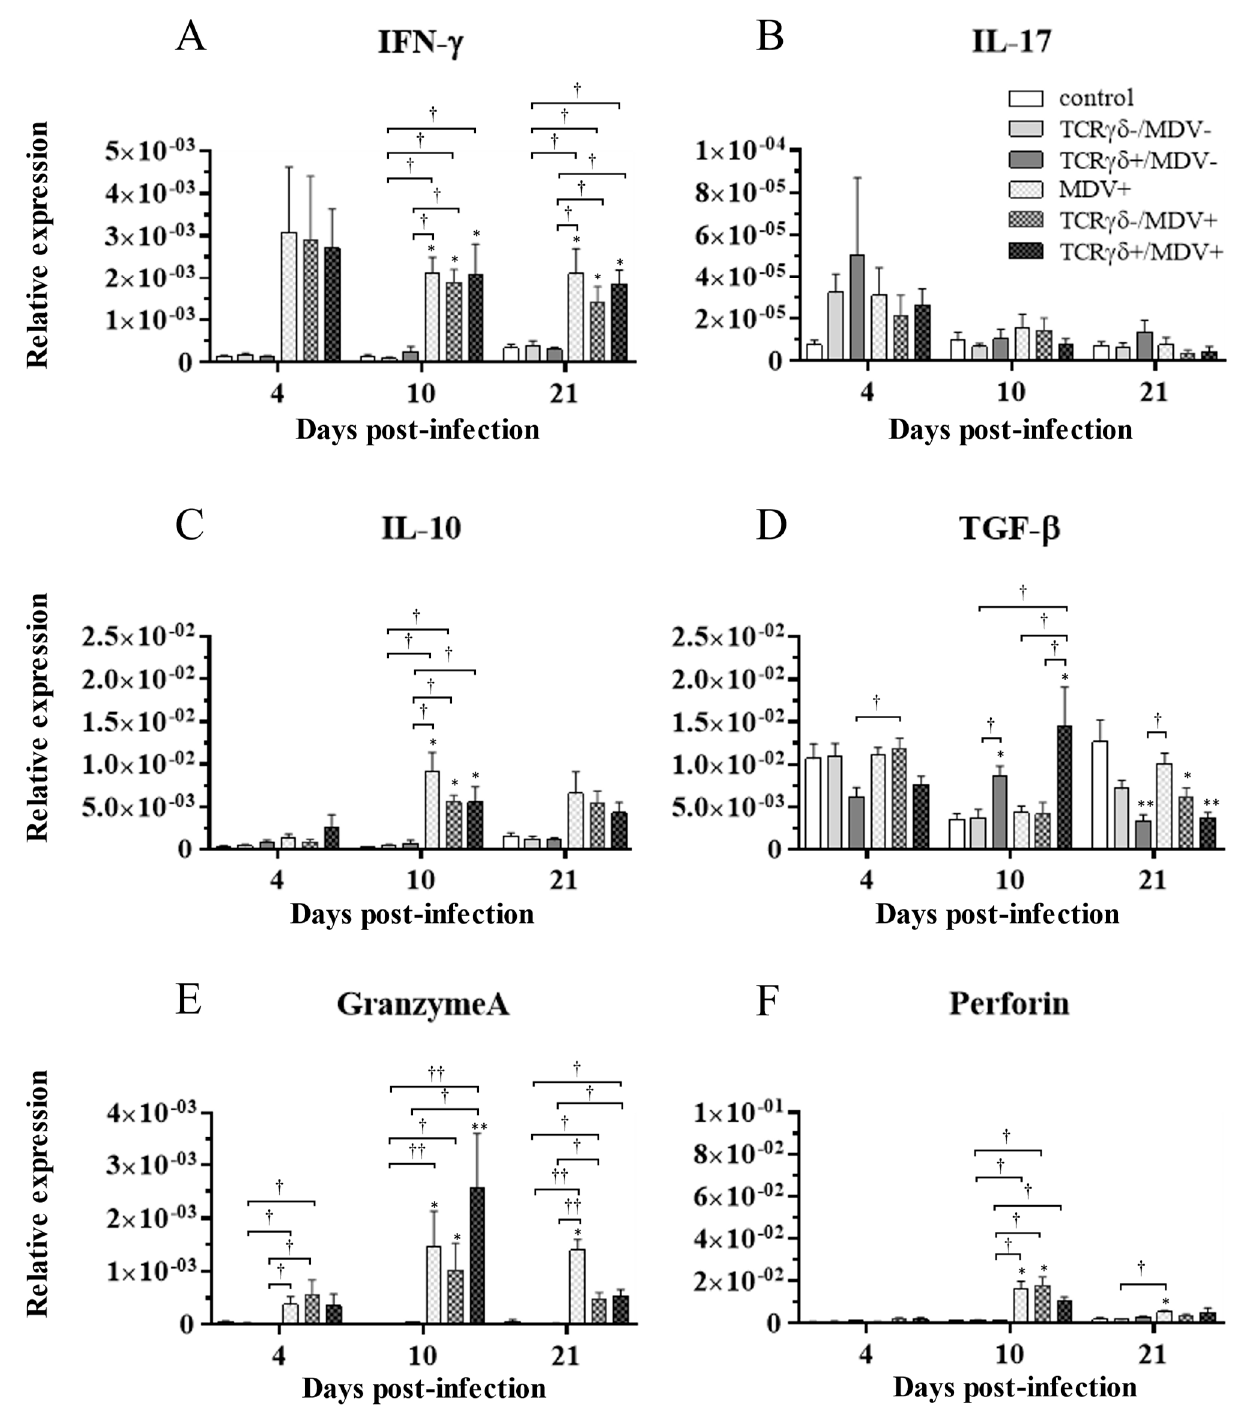
Figure 12. Cytokine, granzyme A, and perforin gene expression profiles in the lungs at 4, 10, and 21 dpi. Gene expression of IFN- γ ( A ), IL-17A ( B ), IL-10 ( C ), TGF- β ( D ), granzyme A ( E ), and perforin ( F ) in the lungs collected from the control, TCR γδ -/MDV-, the TCR γδ +/MDV-, the MDV+, the TCR γδ -/MDV+, and the TCR γδ +/MDV+ groups at 4, 10, and 21 dpi was determined by real-time PCR. Target genes were normalized by β -actin. Data represent the mean of 5 biological replicates ± SE in each group at each time point. Significant differences are indicated by *: p < 0.05 (vs. control), **: p < 0.01 (vs. control), †: p < 0.05, and ††: p < 0.01.